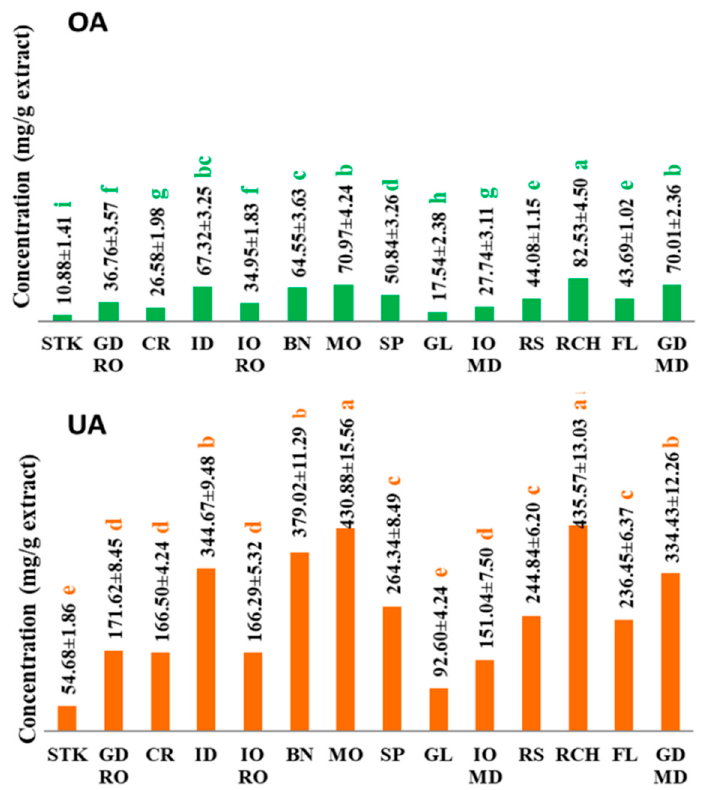
Figure 2. Oleanolic acid (OA) and ursolic acid (UA) content in extracts of different apple cultivars (STK-Starkrimson, GD-Golden Delicious from Romania, CR-Cretesc, ID-Idared, IO RO-Jonathan from Romania, BN-Beliy Naliv, MO-Montuan, SP-Spartan, GL-Gloster, IO MD-Jonathan from Republic of Moldova, RS-Renet Simirenco, RCH-Richard, FL-Florina, GD MD–Golden Delicious from the Republic of Moldova) as means ± SD. Different letters denote significant differences according to Duncan test p ≤